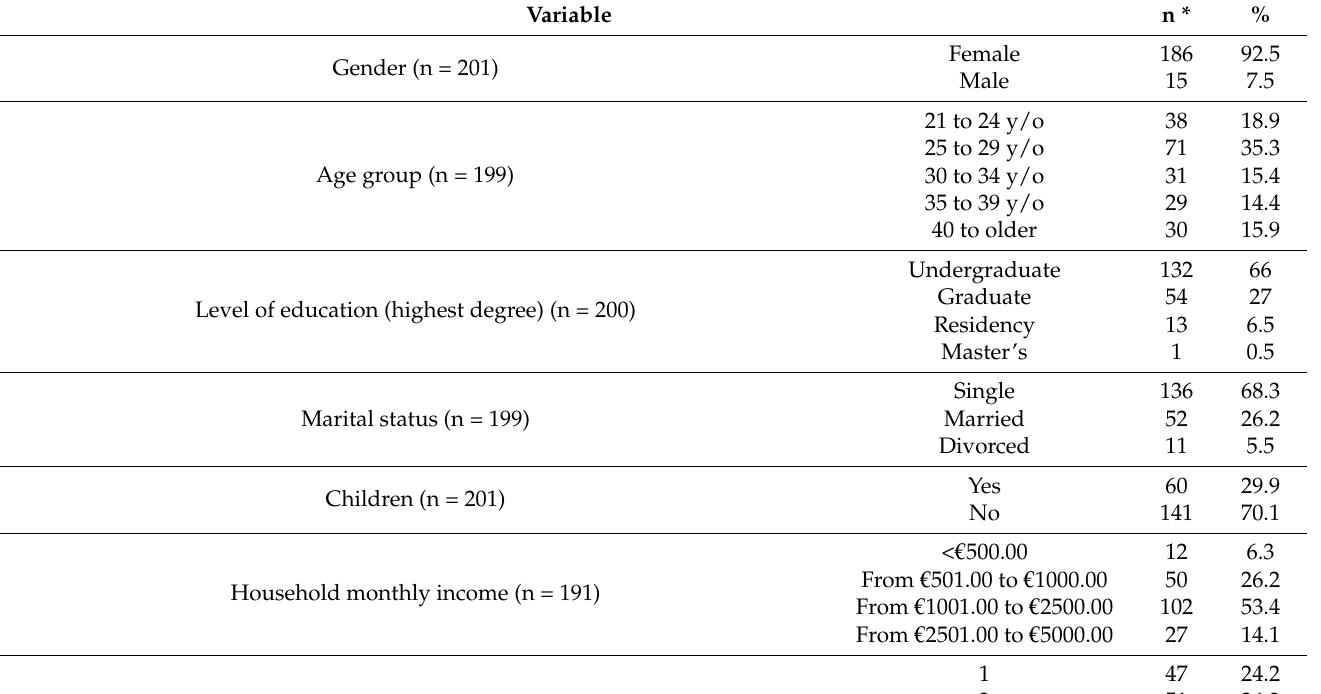
Table 1. Socioeconomic and demographic variables of Portuguese nutritionists.